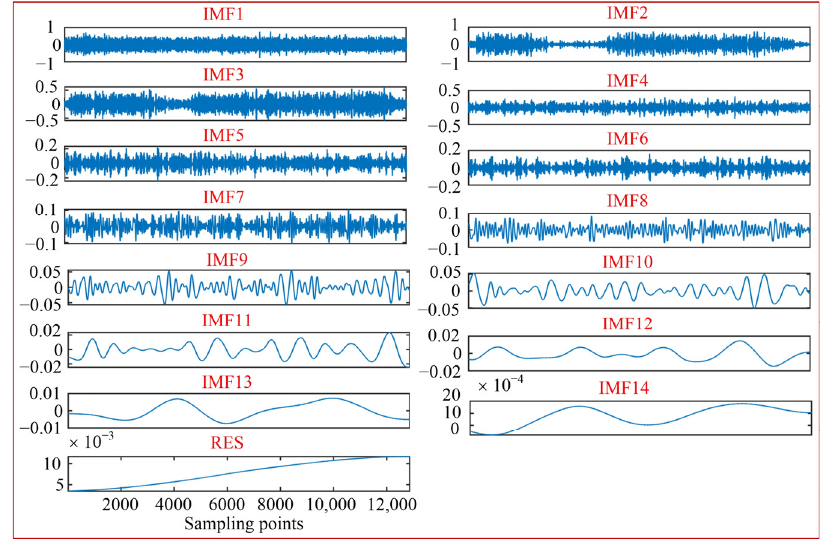
Figure 6. IMF components of each order with residual signal (SNR in = 10 dB).